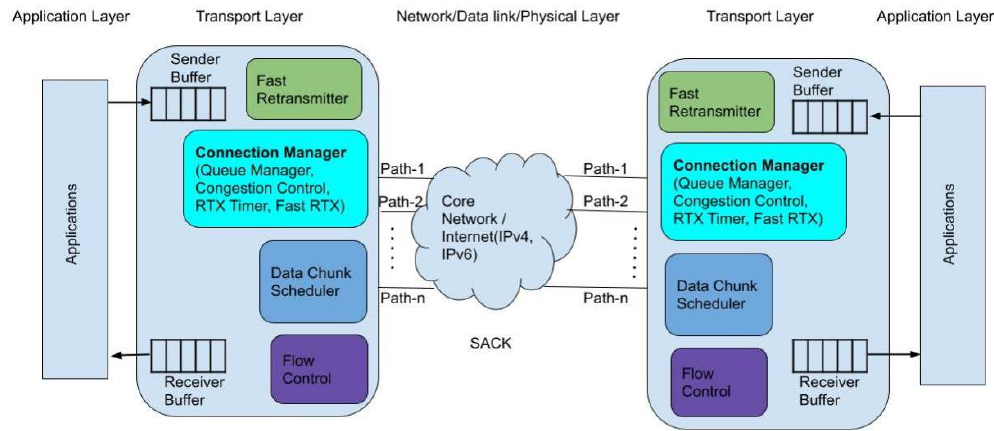
Figure 5. CMT protocol stack architecture.